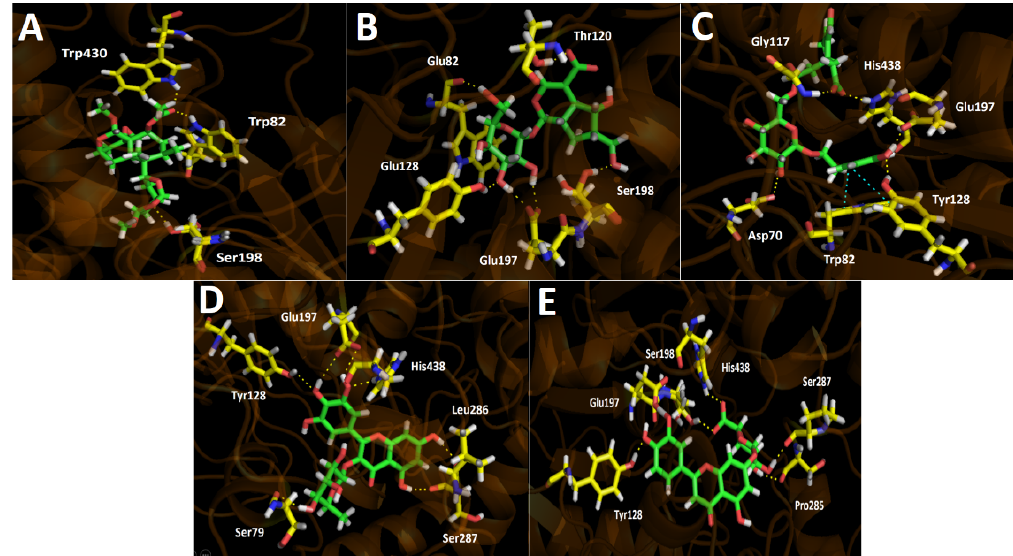
Figure 5. Predicted binding mode and predicted intermolecular interactions of the selected major compounds in Gaultheria pumila berries extract and the residues of the human butyrylcholinesterase ( h BuChE) catalytic site. Yellow dotted lines indicate hydrogen bond interactions and cyan dotted lines represent π – π interactions. ( A ) Scupolin I in the catalytic site; ( B ) Unedide in the catalytic site; ( C ) Nuzhenal B in the catalytic site; ( D ) Myricetin O -rhamnoside in the catalytic site; and ( E ) Luteolin 7-glucuronide in the catalytic site.